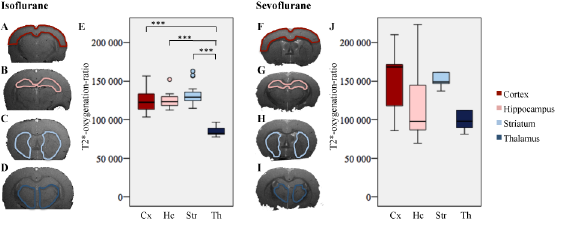
Figure 3. Comparison of T2*-oxygenation-ratio of volatile anesthetics among brain regions. Images are coronal T2* MRI sections acquired in vivo under general anesthesia using isoflurane (A: cortex, B: hippocampus, C: striatum, D: thalamus) or sevoflurane (F: cortex, G: hippocampus, H: striatum, I: thalamus). Box plots represent median, 25 th and 75 th percentile, minimum and maximum values, outliers ( u ) and extremes (*). Y-axis: regional T2*-oxygenation-ratio. X- axis: Cx, cortex; Hc, hippocampus; Str, stiatum; Th, thalamus. E: T2*- oxygenation-ratio for isoflurane. The thalamus had a lower oxygenation level than the other studied brain regions. J: T2*-oxygenation-ratio for sevoflurane. No significant difference was observed between the studied brain regions. *** p ,